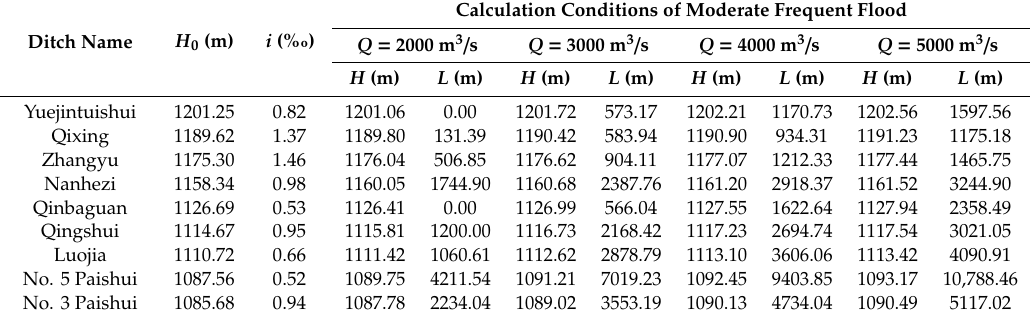
Table 2. Analysis of the lengths of the backward flows in the main dike-through drainage ditches of the